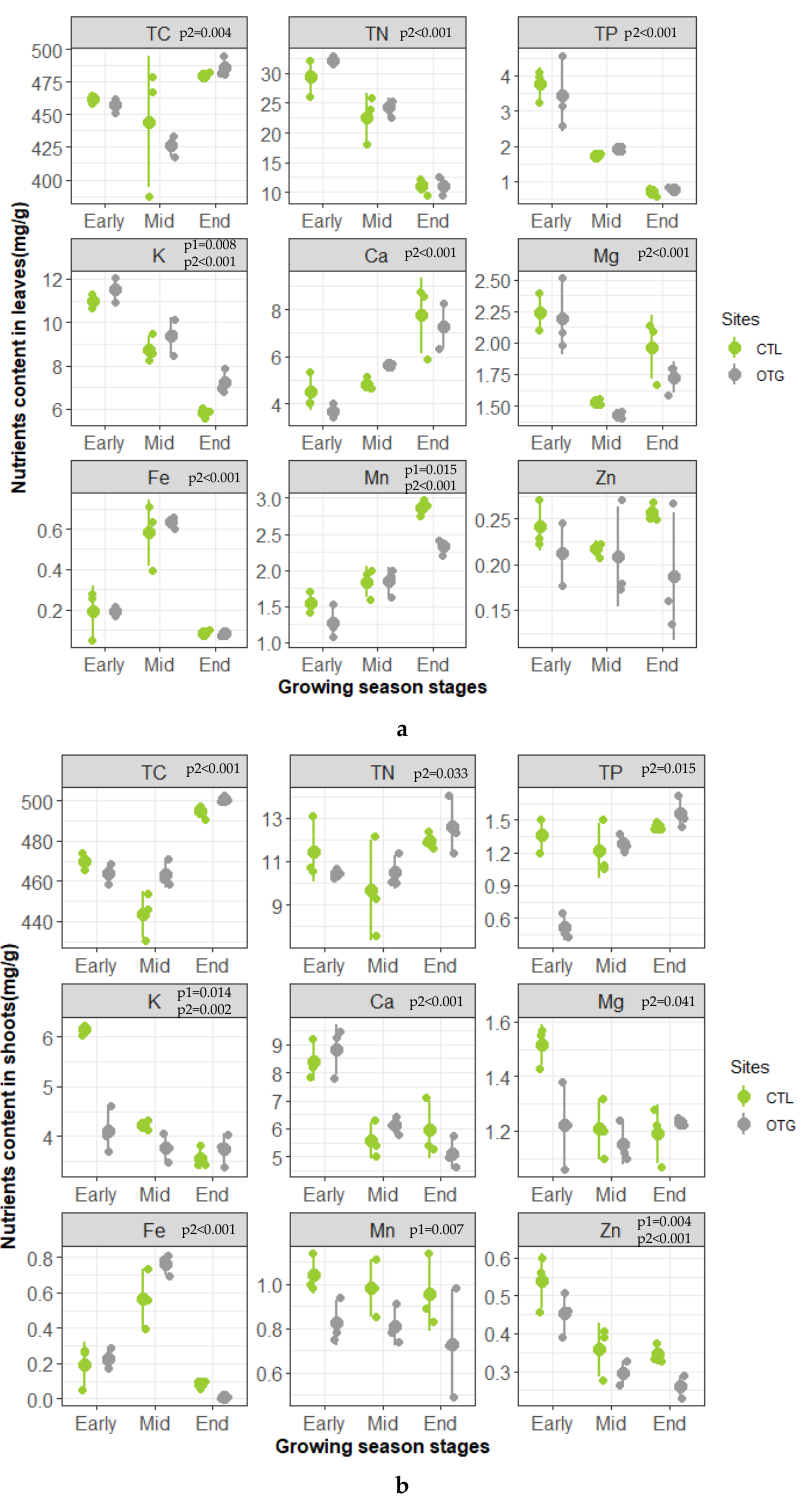
Figure 4. Nutrient contents in leaves (a) and shoots (b) of Erman’s birch trees growing at the continuous treeline (CTL) and outposts beyond the treeline (OTG) on Changbai Mountain. The full data (scatter points) is shown on the figures, with large points show Mean ± SD. The p values from two-way ANOVA were shown in the figures, p1 represents difference between sites, while p2 represents difference between growing stages.